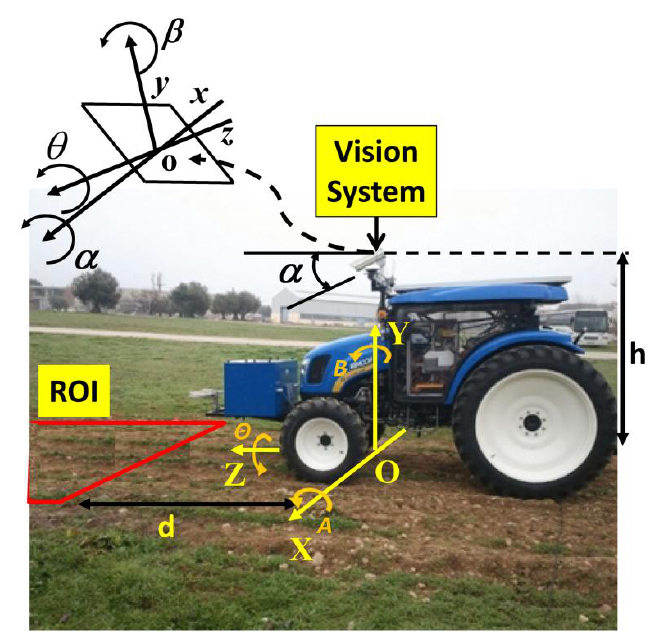
Figure 5. Camera system